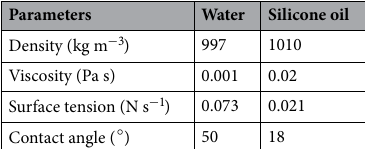
Table 3. Liquid parameters used in Washburn’s